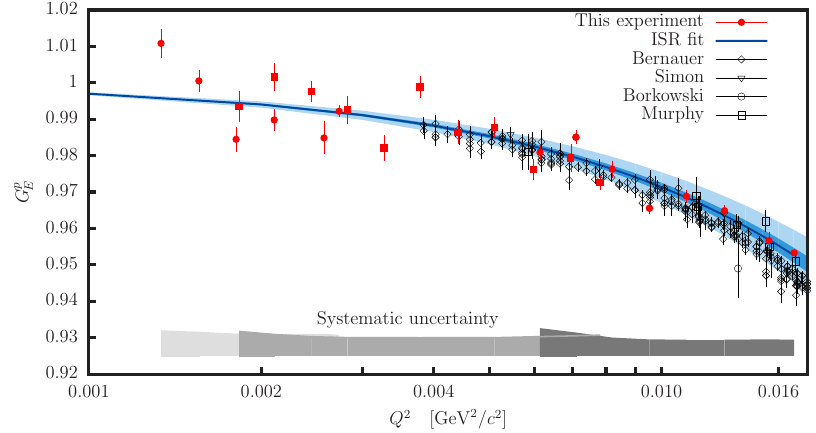
Figure 2. The proton electric form factor as a function of Q 2 ( = Q 2 ). Empty black points show previous data. Out The results of this experiment are shown with full red circles. The error bars show statistical uncertainties. Grey structures at the bottom shows the systematic uncertainties for the three energy settings. The curve corresponds to a polynomial fit to the data defined by Eq. (1). The inner and the outer bands around the fit show its uncertainties, caused by the statistical and systematic uncertainties of the data, respectively. See Ref. [7] and references